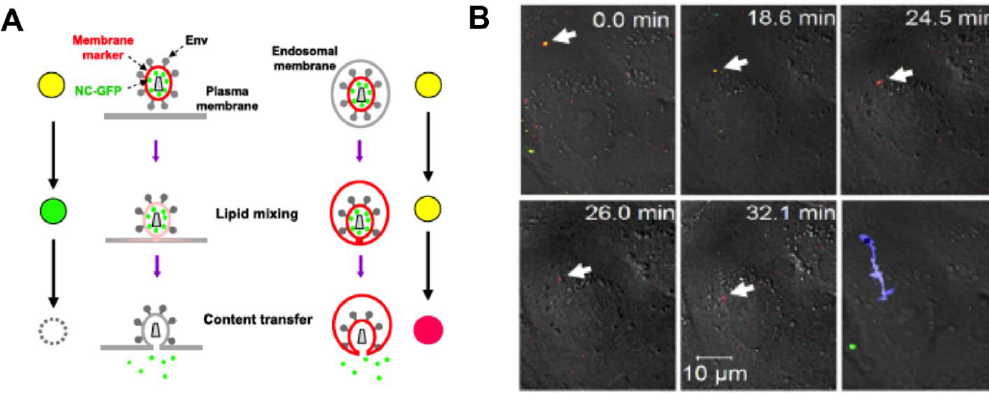
Figure 2. Fluorescence microscopy imaging of viral fusion: ( A ) Schematic of doubly labeled HIV-1 viral particles entering into the cell by fusion with the plasma membrane (left) or with the endosomal membrane (right). ( B ) A complete fusion of HIV-1 (JRFL strain) with endosomal membrane is evidenced by the loss of the green fluorescence signal due to the content release, and the incorporation of the red membrane stain into the endosomal membrane. The blue trace on the last image represents the intracellular trajectory of a viral particle. (Reproduced with permission from [45], copyright 2009, Elsevier).